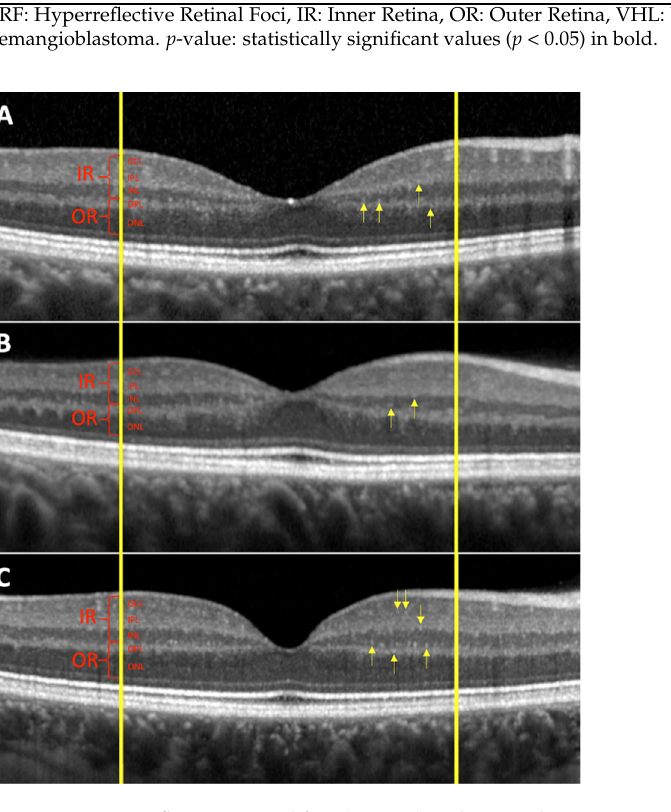
Figure 1. Hyperreflective retinal foci (arrows) at the OCT linear scan in one healthy control ( A ), in one VHL eye with retinal hemangioblastoma ( B ), and in one VHL eye without retinal hemangioblastoma ( C ) are shown. IR: Inner Retina; OR: Outer Retina; GCL: Ganglion Cell Layer; IPL: Inner Plexiform Layer; INL: Inner Nuclear Layer; OPL: Outer Plexiform Layer; ONL: Outer Nuclear Layer. The above-mentioned OCT differences (pRNFL, mRNFL, GCL, and HRF) between controls and VHL groups and between VHL patients with and without RH are reported in Figure 2.